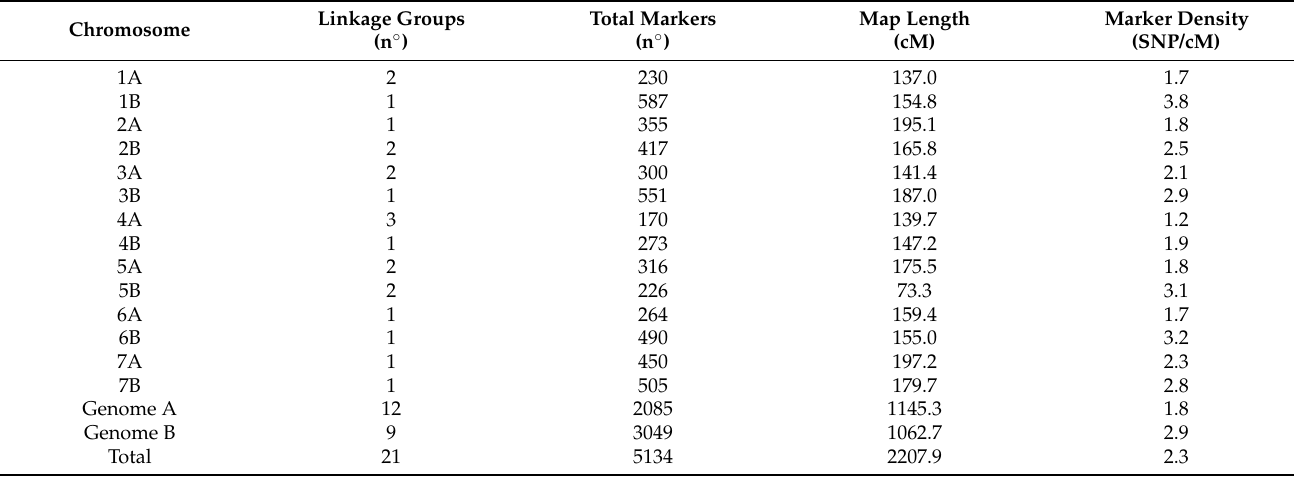
Table 4. Distribution of single nucleotide polymorphism (SNP) markers across the 14 durum wheat chromosomes in the genetic linkage map Liberdur x Anco Marzio RILs mapping population.